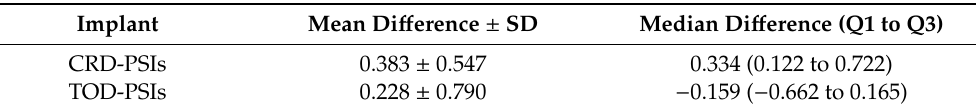
Table 2. Overall results (mm) of the CRD-PSIs and TOD-PSIs compared to the corresponding 3D printed template.